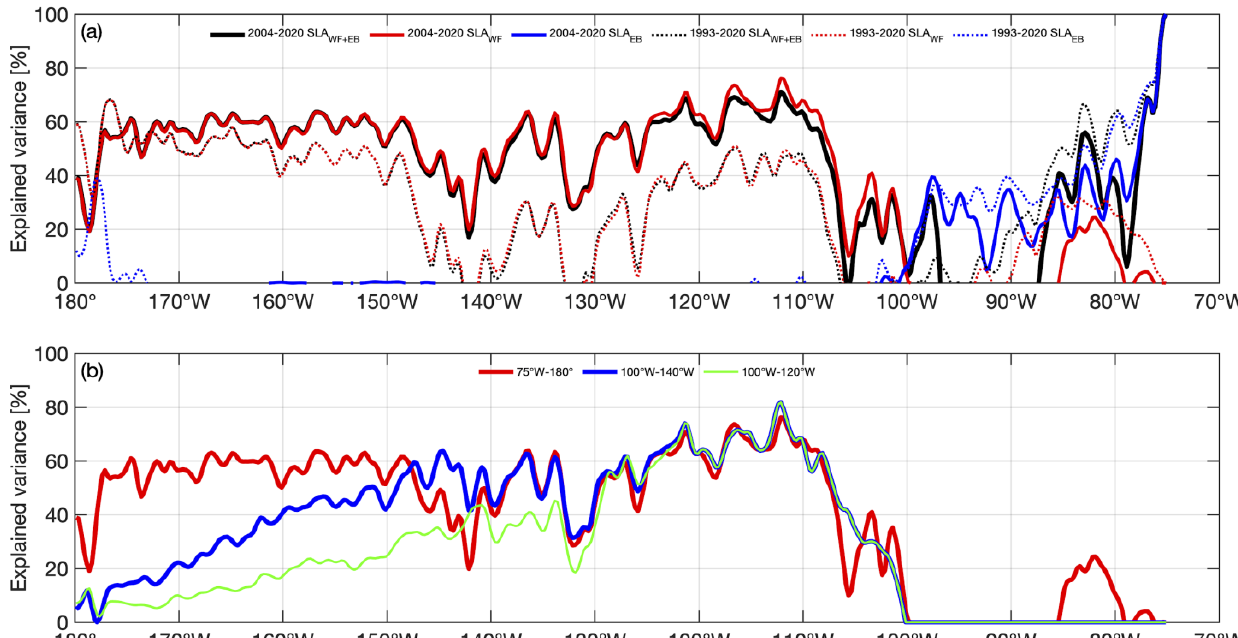
Figure 10. ( a ) Fraction of variance (%) of the South Pacific interannual sea level anomaly (SLA) explained by the 1.5 layer reduced-gravity model from 180° to 75°W and averaged between 34°S and 36°S during 2004 – 2020 (solid lines) and for the period of 1993 – 2020 (dotted lines). The fraction of variance attributed to the combined effects of the wind-stress and eastern boundary forcing terms is in black; the fraction of variance due to the wind-stress forcing only is in red, and that of the boundary forcing only is in blue. ( b ) Fraction of SLA variance (%) attributed to the wind-stress forcing in the 180° – 75°W band (red line; as in ( a )), the 140°W – 100°W band (blue line) and the 120°W – 100°W band (green line) for the period of 2004 – 2020.